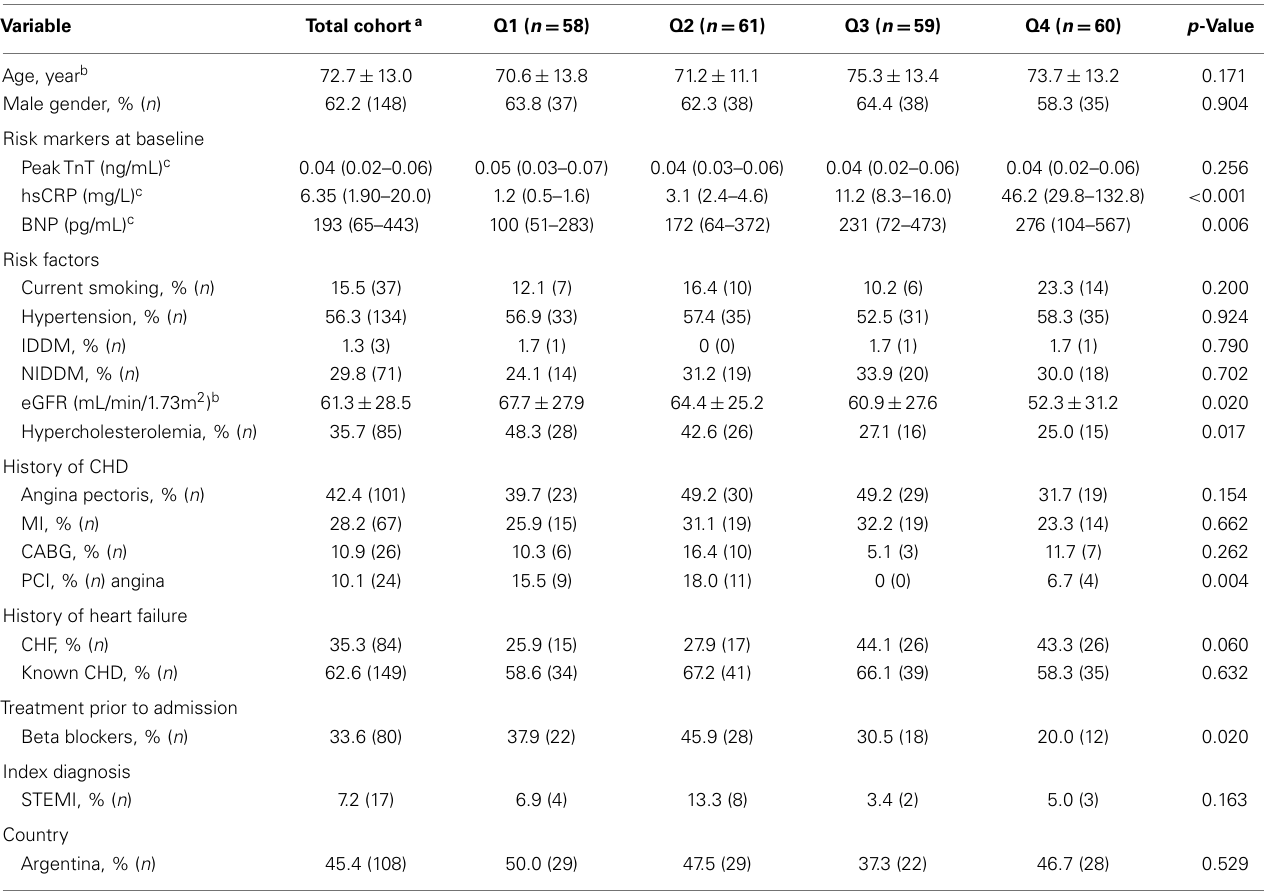
Table 2 | Baseline characteristics according to hsCRP (mg/L) quartiles